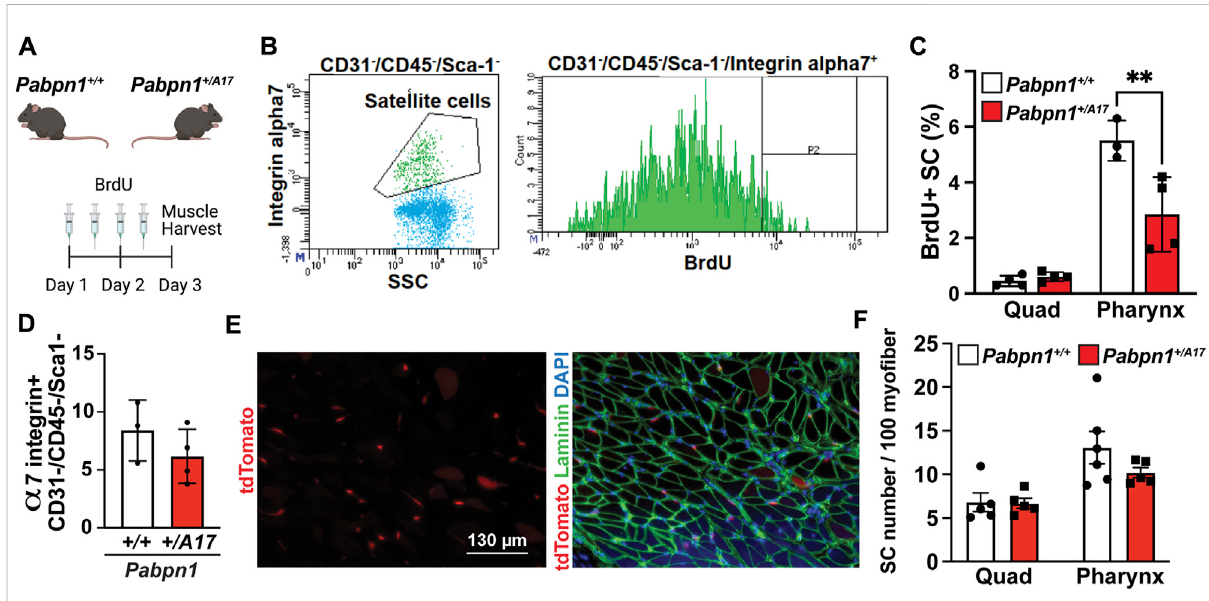
FIGURE 4 Proliferation of pharyngeal satellite cells is impaired in Pabpn1 +/A17 mice (A) Schematic of 2-day bromodeoxyuridine (BrdU) injection in Pabpn1 +/+ and Pabpn1 +/A17 mice. (B) Representative scatter plot (left) showing gating strategy to identify satellite cells as CD31 − /CD45 − /Sca1 − / α 7- integrin + and histogram (right) showing gating strategy for BrdU + satellite cells. (C) BrdU + cells as percentage of total satellite cells (SC) revealing decreased BrdU + SC in pharynx from Pabpn1 +/A17 mice but no change in quadriceps muscles (Quad). (D) Total number of pharyngeal CD31 − / CD45 − /Sca1 − / α 7-integrin + satellite cells as a percentage of mononucleated cells showing no change in Pabpn1 +/A17 mice. (E) Representative cross- sectioned images of cricopharyngeus muscle showing tdTomato positive satellite cells in isolation (left) or merged with laminin-stained myo fi bers (right). Bar = 130 µm. (F) Number of tdTomato positive satellite cells (SC) per 100 myo fi bers quanti fi ed from sectioned quadriceps (Quad) and cricopharyngeus (Pharynx) muscles showing no change in Pabpn1 +/A17 mice. Shown is mean ± SEM for n = 3 – 5 mice. Statistical signi fi cance was determined using two-way ANOVA (** p <